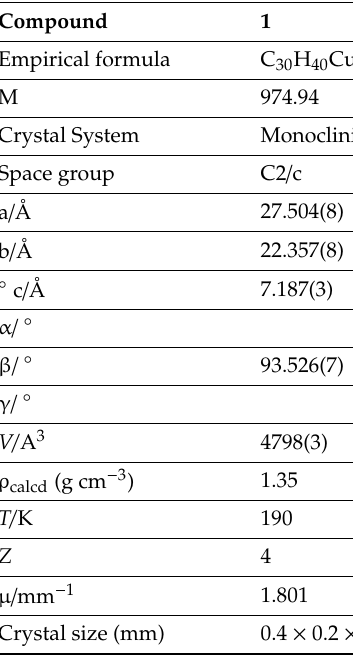
Table 2. Summary of crystallographic data for compounds 1 – 6